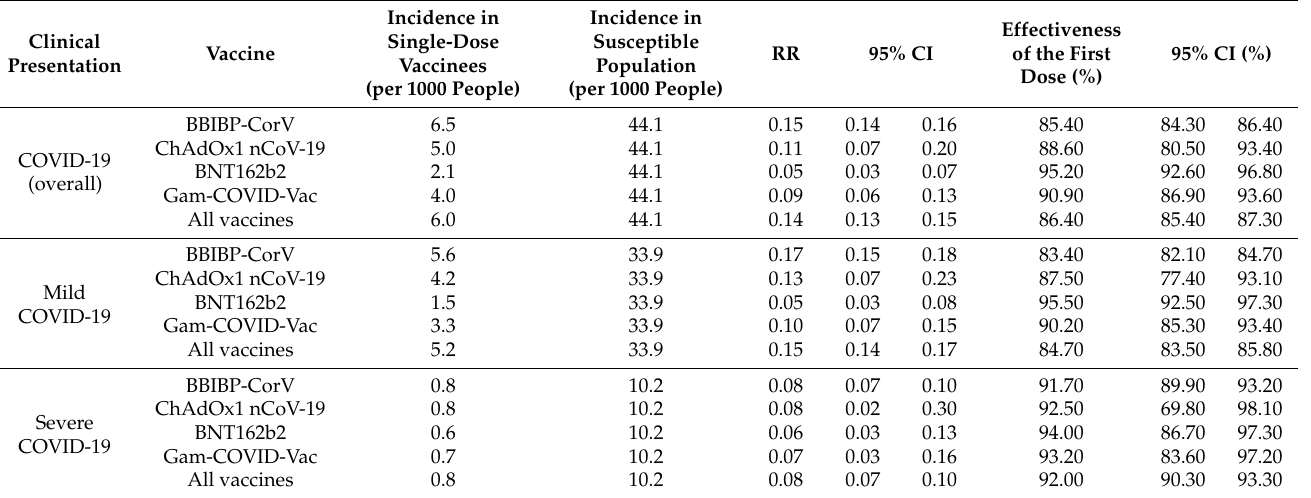
Table 1. Estimated effectiveness of the first dose of SARS-CoV-2 vaccines against COVID-19 outcomes, by clinical presentation and type of vaccine.